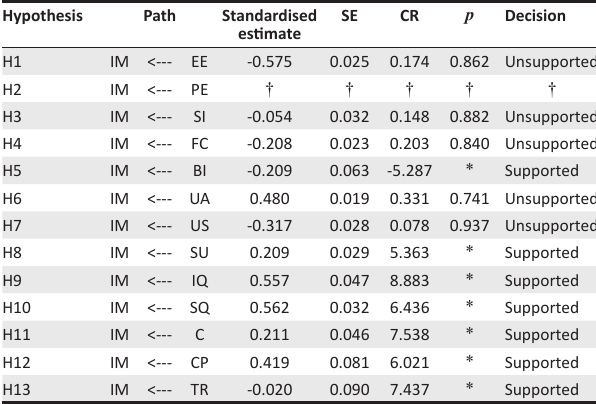
TABLE 5: Hypothesis testing. Hypothesis Path Standardised